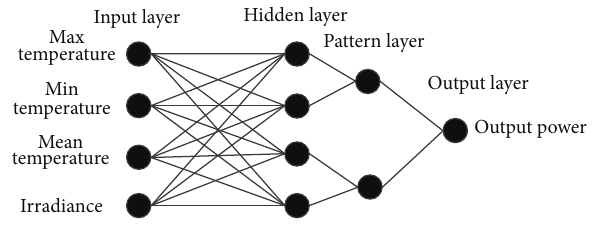
Figure 2: Architecture of GRNN.